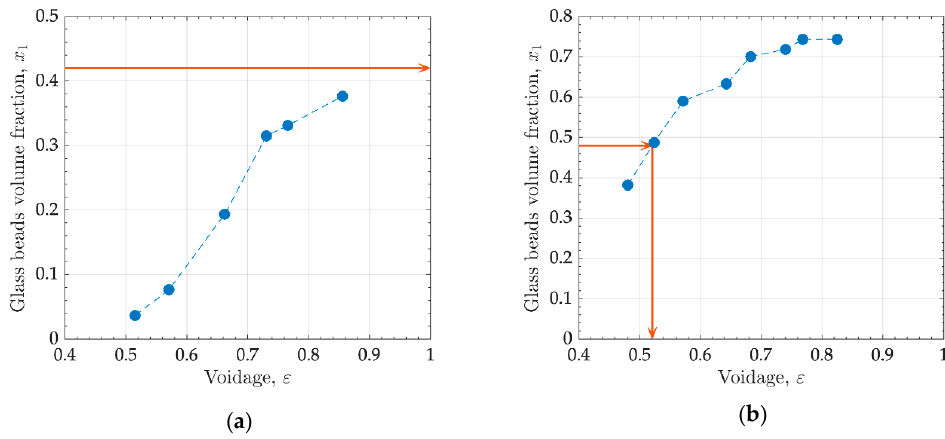
Figure 7. Representative trends of the concentration of the uppermost layer as a function of the expansion (voidage). As indicated by the presence or absence of the intersection of the profile with the nominal concentration (red arrow), for system GB4_PS3_X1_0.42 ( a ) the inversion condition is not reached in the investigated range and for system GB5_PS5 _X1_0.48 ( b ) layer inversion is found to occur.